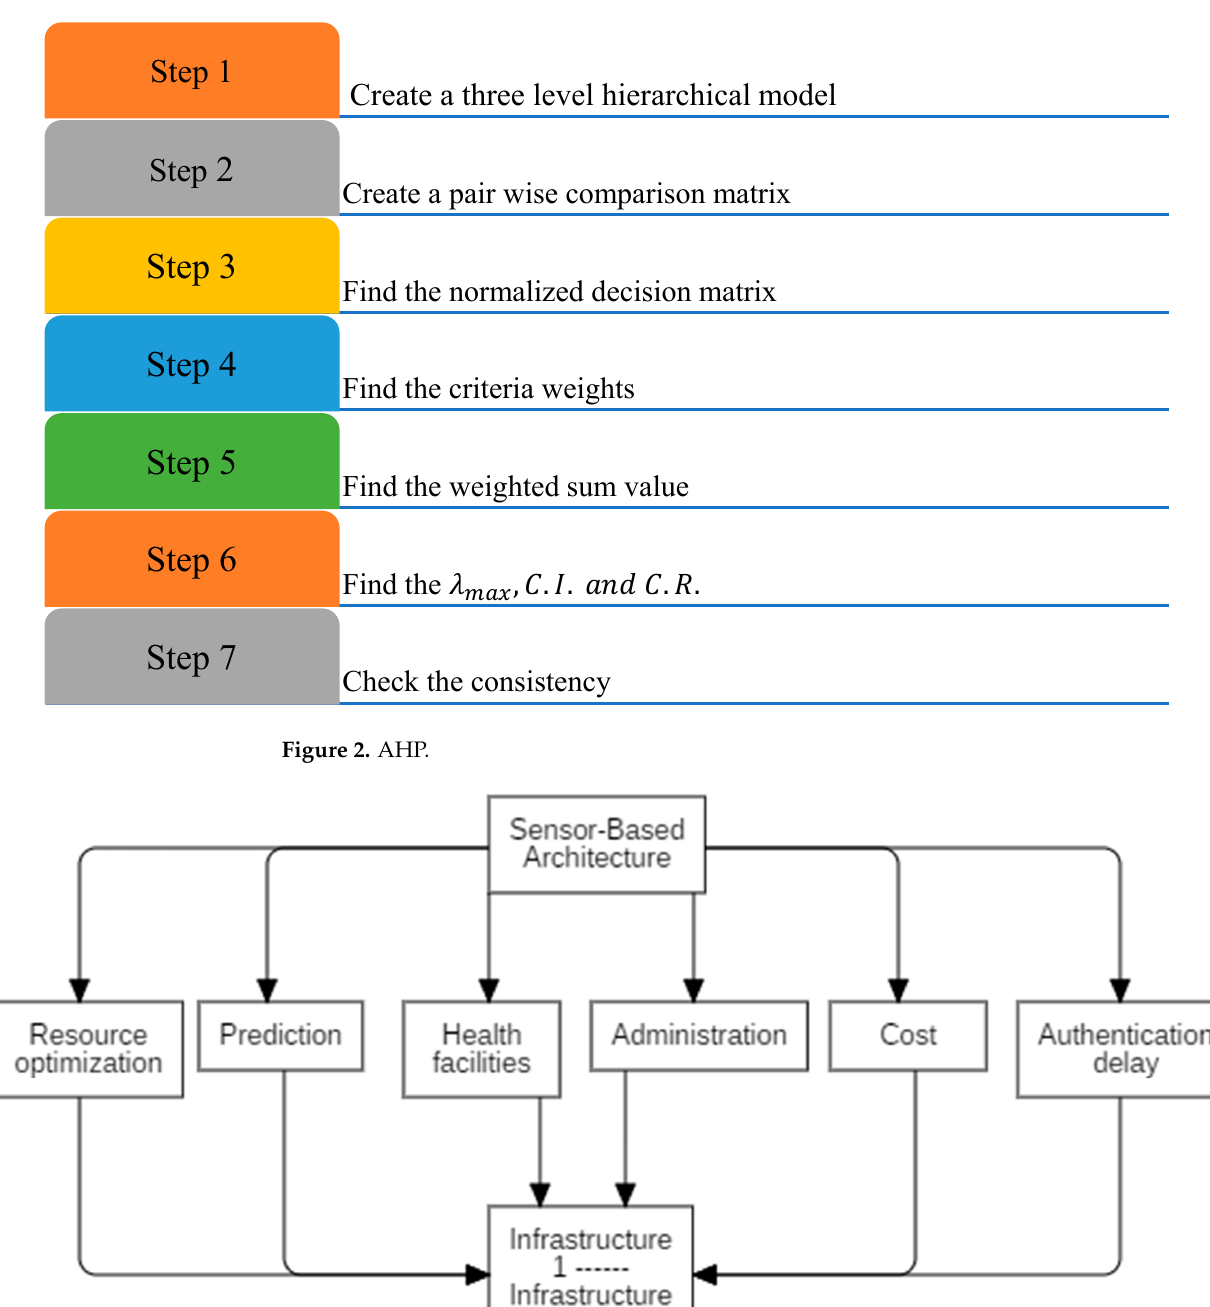
Figure 3. Hierarchical Diagram. Pair-Wise Comparison Matrix. By providing each attribute with a precise score on the Saaty scale, based on the needs of the person in charge, a matrix is created. The pair-wise comparison matrix for the current condition is shown in Table 3.